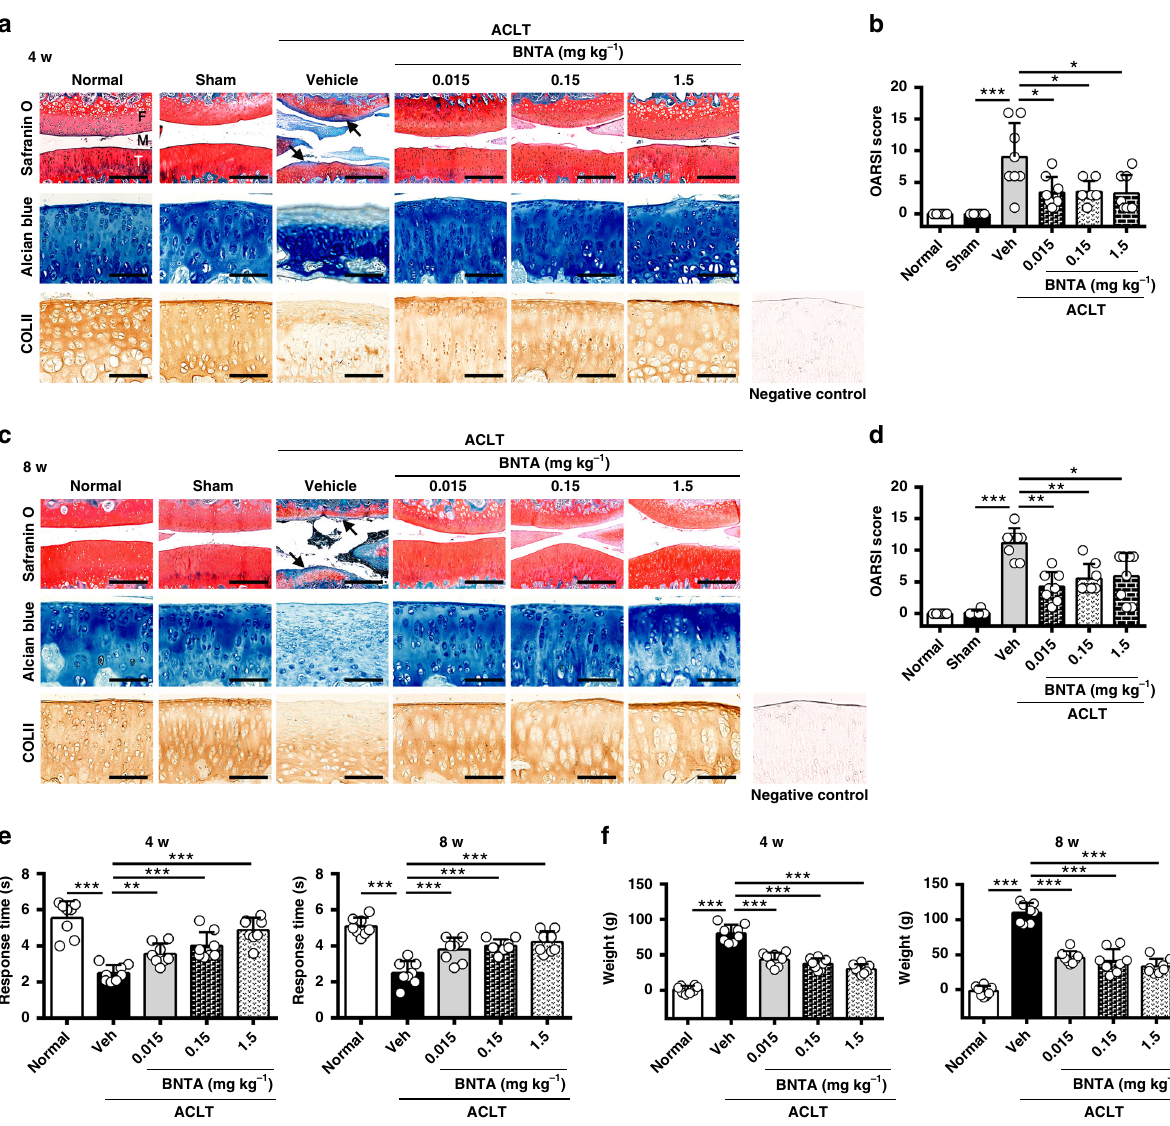
Fig. 3 BNTA attenuated post-traumatic osteoarthritis development after intra-articular injection for 4 and 8 w. a , b Representative images of safranin O- fast green, alcian blue, immunohistochemistry staining of type II collagen (COLII), and the corresponding Osteoarthritis Research Society International (OARSI) scores from normal, sham, veh (vehicle)-treated, and BNTA-treated rats at 4 w ( n = 8 for each group; nonparametric test; M, meniscus; F, femur; T, tibia; safranin O-fast green staining, scale bar, 200 μ m; alcian blue and immunohistochemistry staining, scale bar, 100 μ m). c , d Representative images of safranin O-fast green, alcian blue, immunohistochemistry staining of COLII, and OARSI scores in normal, sham, vehicle, and BNTA rats at 8 w ( n = 8 for each group; nonparametric test; safranin O-fast green staining, scale bar, 200 μ m; alcian blue and immunohistochemistry staining, scale bar, 100 μ m). e Pain response times when rats were placed on the 55 °C hot plate meter at 4 w and 8 w post-surgery ( n = 8 for each group, one-way ANOVA). f The difference between the weight placed on the contralateral sham (left) hindlimb and the weight placed on the anterior cruciate ligament transection (ACLT, right) one at 4 w and 8 w post-surgery ( n = 8 for each group, one-way ANOVA). Each data point represents one individual rat. All data are shown as the mean ± standard deviation (s. d.). * P < 0.05, ** P < 0.01, *** P < 0.001. Source data are provided as a Source Data fi